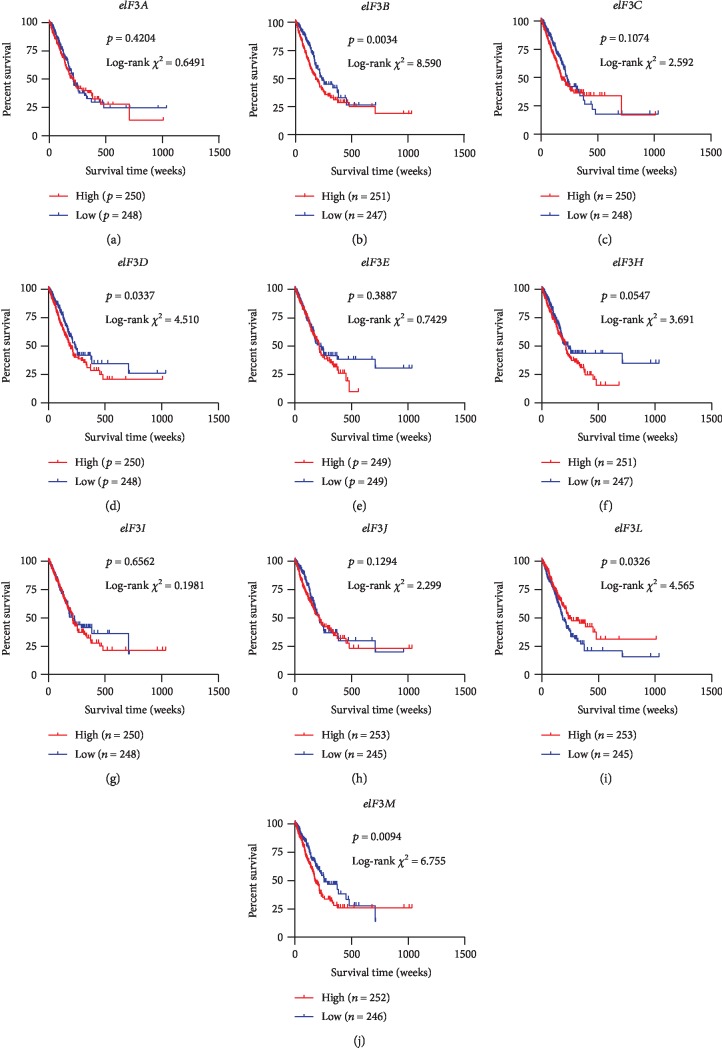
Kaplan-Meier survival analysis of differentially expressed subunits of eIF3 for OS in LUAD patients. χ2 and p values assessed by log-rank test and number of patients in each group are provided in the figure.